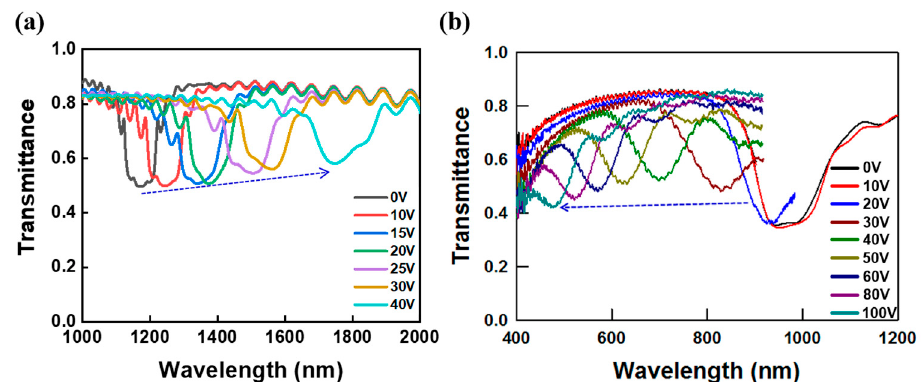
Figure 4. ( a ) Red and ( b ) blue-tuning PSCLCs containing 10 wt. %